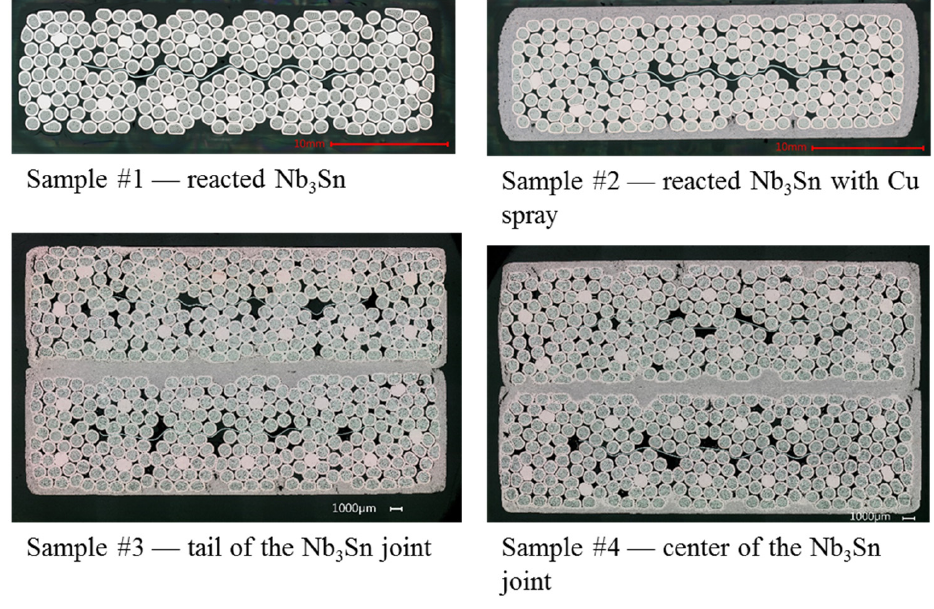
Figure 6. Samples for the micrographic analysis.